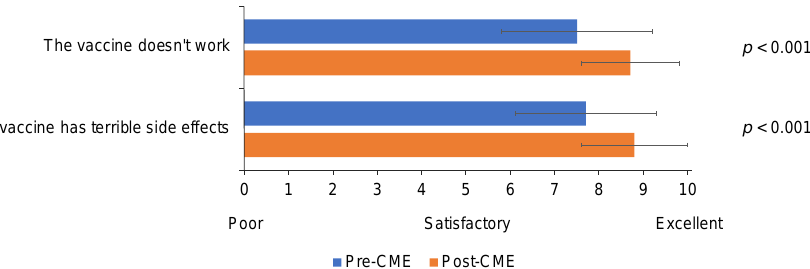
Figure 2. Self-reported rating on a scale of 1–10 of general practitioners’ (n = 159) confidence in their ability to address potential reasons for influenza vaccine hesitancy by patients before and after participating in an accredited continuing medical education (CME) program.